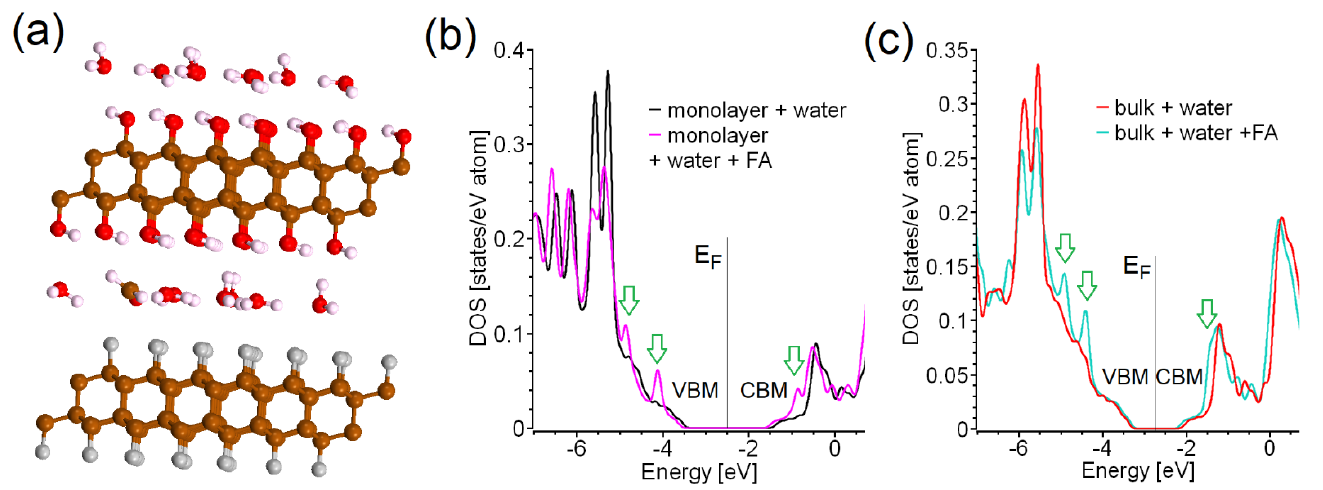
Figure 4. Side view of optimized atomic structure of C 2 F/C 2 OH single layer with acetone molecule physically adsorbed on F-terminated side ( a ), and total densities of states of the C 2 F/C 2 OH single layers before and after adsorption of acetone on different sides (terminations) ( b ). The color scale of the atoms in panel ( a ) is the same as in Figure 1.